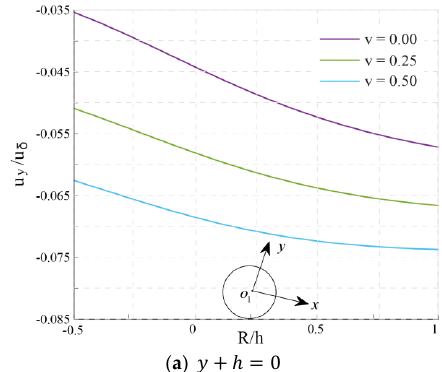
Figure 13. Maximum vertical displacement.